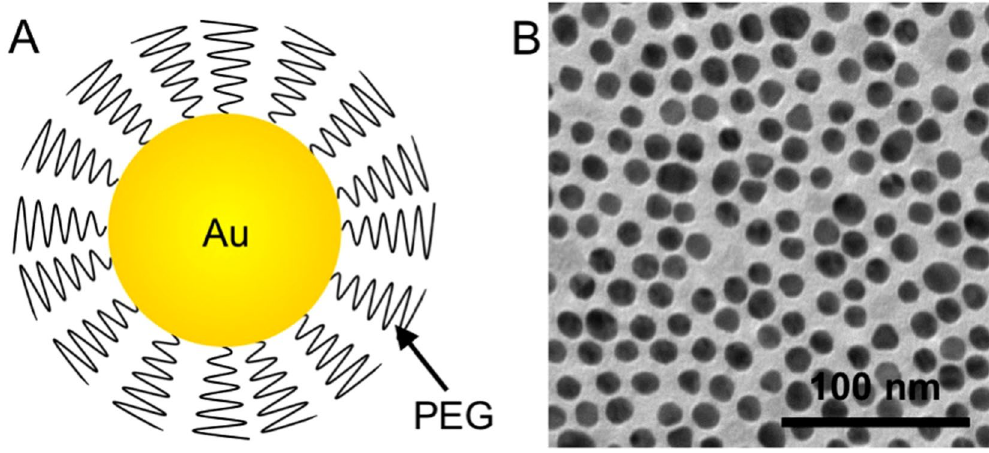
Figure 2. ( A ) Schematic representation of the gold nanoparticle used in this report. ( B ) TEM of the gold nanoparticles.